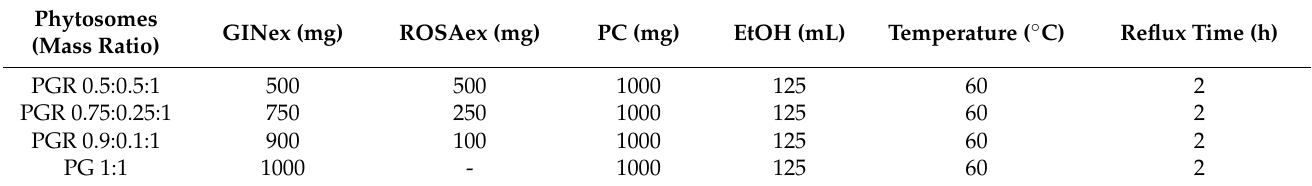
Table 1. Mass ratios of ginger (GINex) and rosehip (ROSAex) extracts and phosphatidylcholine (PC) for PHYTOGINROSA (PGR) and PHYTOGIN (PG)